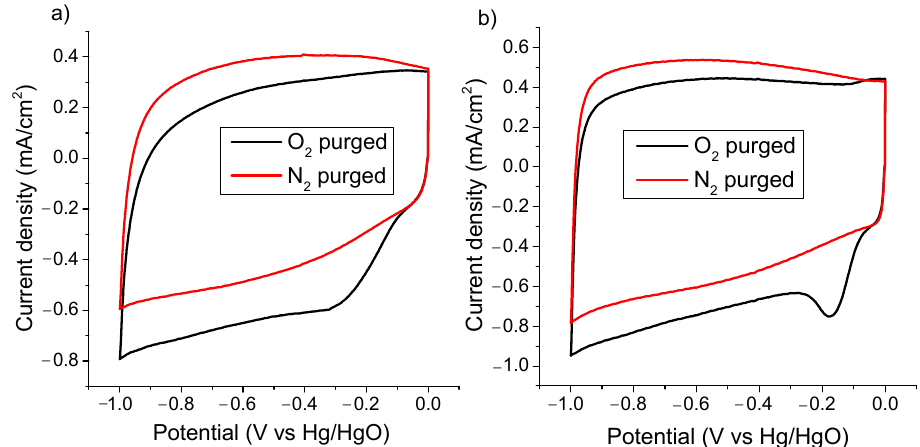
Figure 5. Cyclic voltammograms of ( a ) PNDC and ( b ) SiPNDC at 100 mV/s in 0.1 M KOH under oxygen and nitrogen saturated environment. Table 4. Peak oxygen reduction potential (V vs. Hg/HgO) and current density at 100 mV/s scan rate. Sample